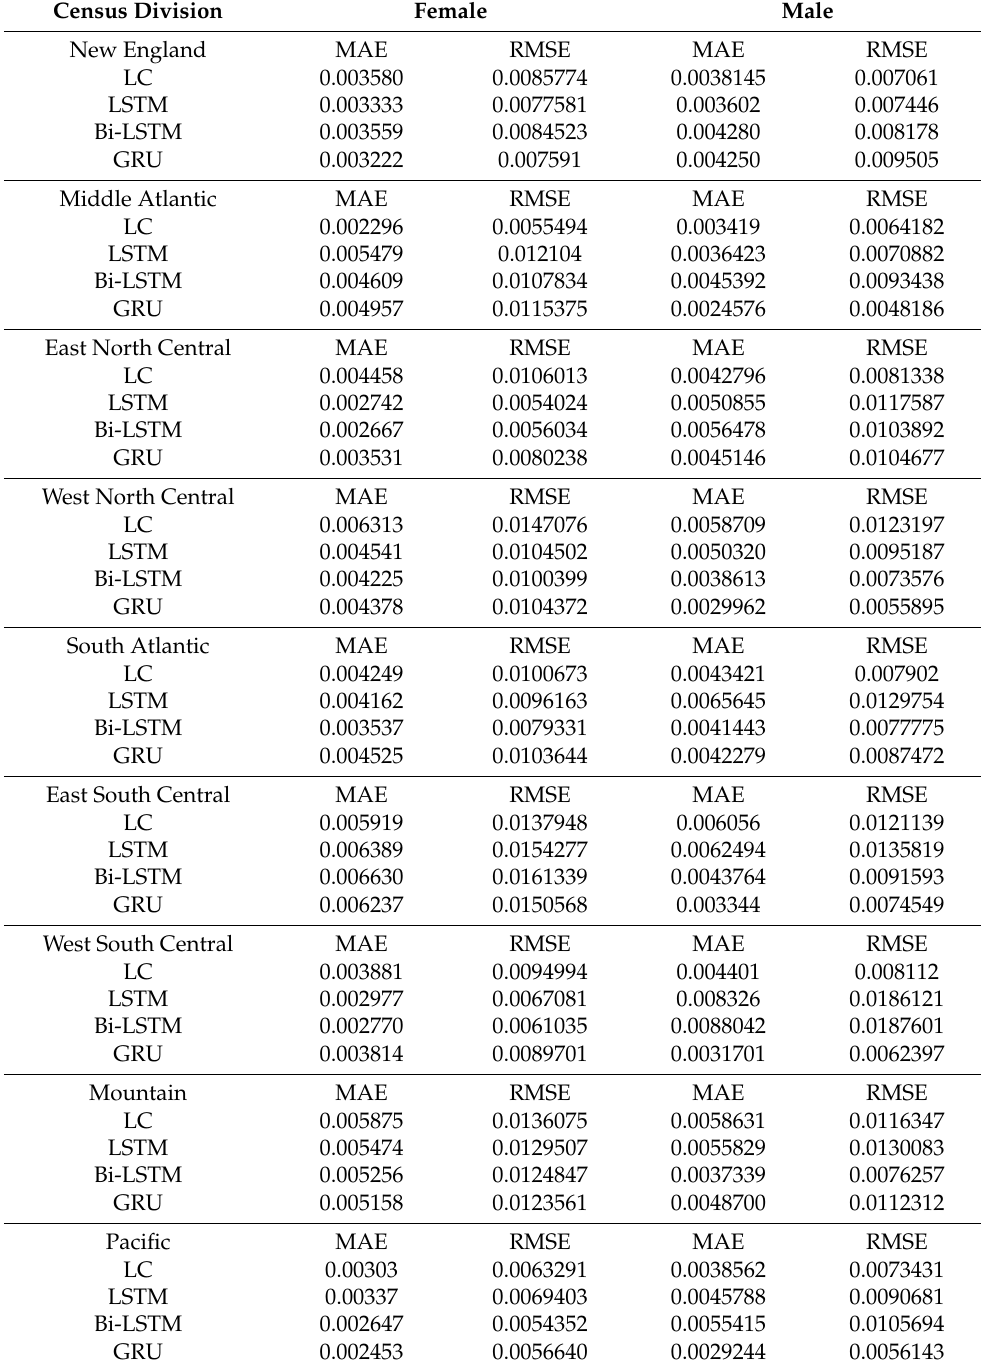
Table 7. MAE and RMSE for the LC, LSTM, Bi-LSTM, and GRU by gender and